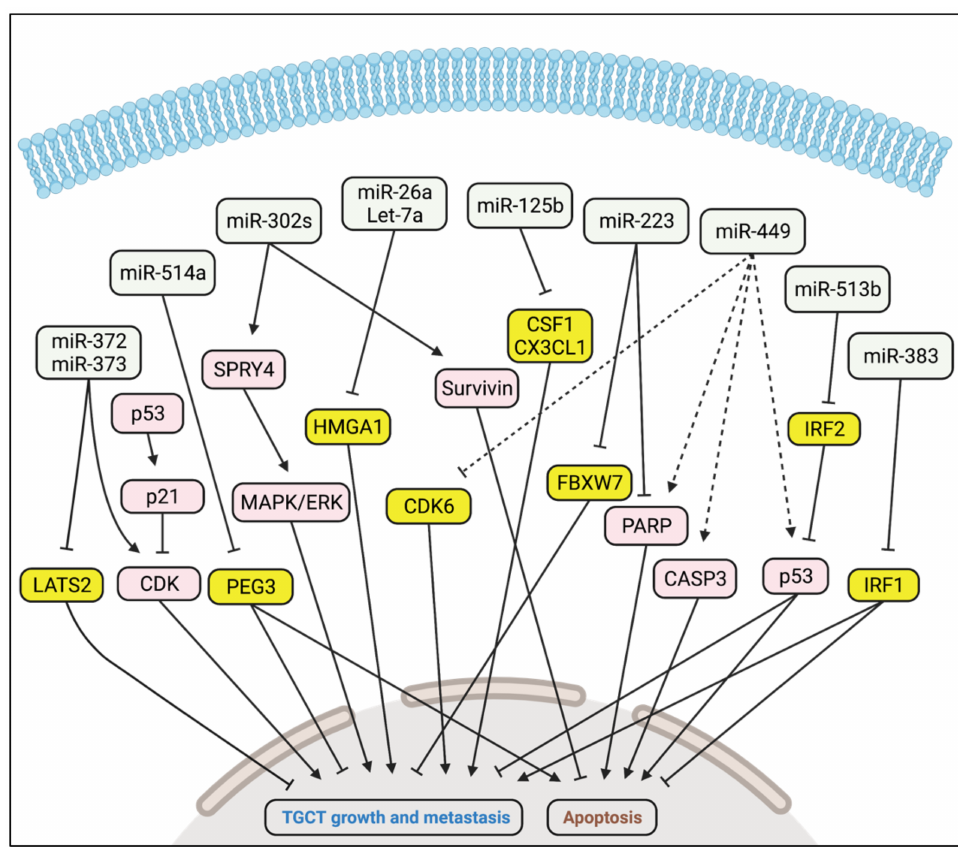
Figure 3. miRNA signalling pathways related to TGCT pathogenesis. Genes affected by miRNAs: yellow boxes represent direct targets, and the pink boxes represent indirect targets involved in TGCT pathogenesis. Solid lines indicate activation or inhibition based on evidence, whereas broken lines indicate hypothesized